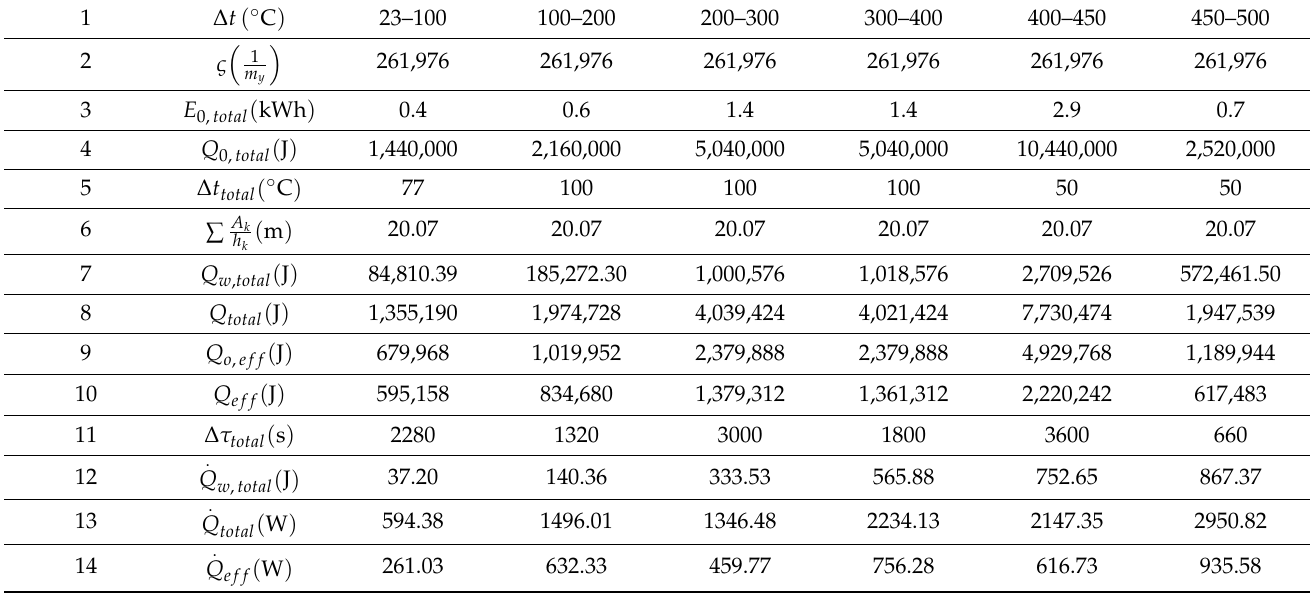
Table 3. Small model, unpainted—scale 1:4; values of the dependent variables by the ML.